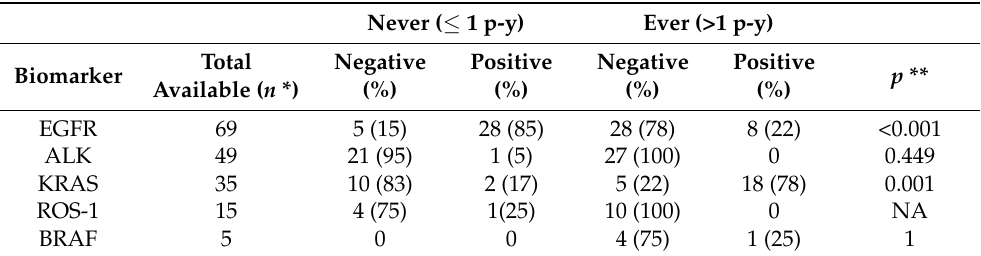
Table 3. Biomarker status of women lung adenocarcinomas in the WTC Environmental Health Center with smoking history.